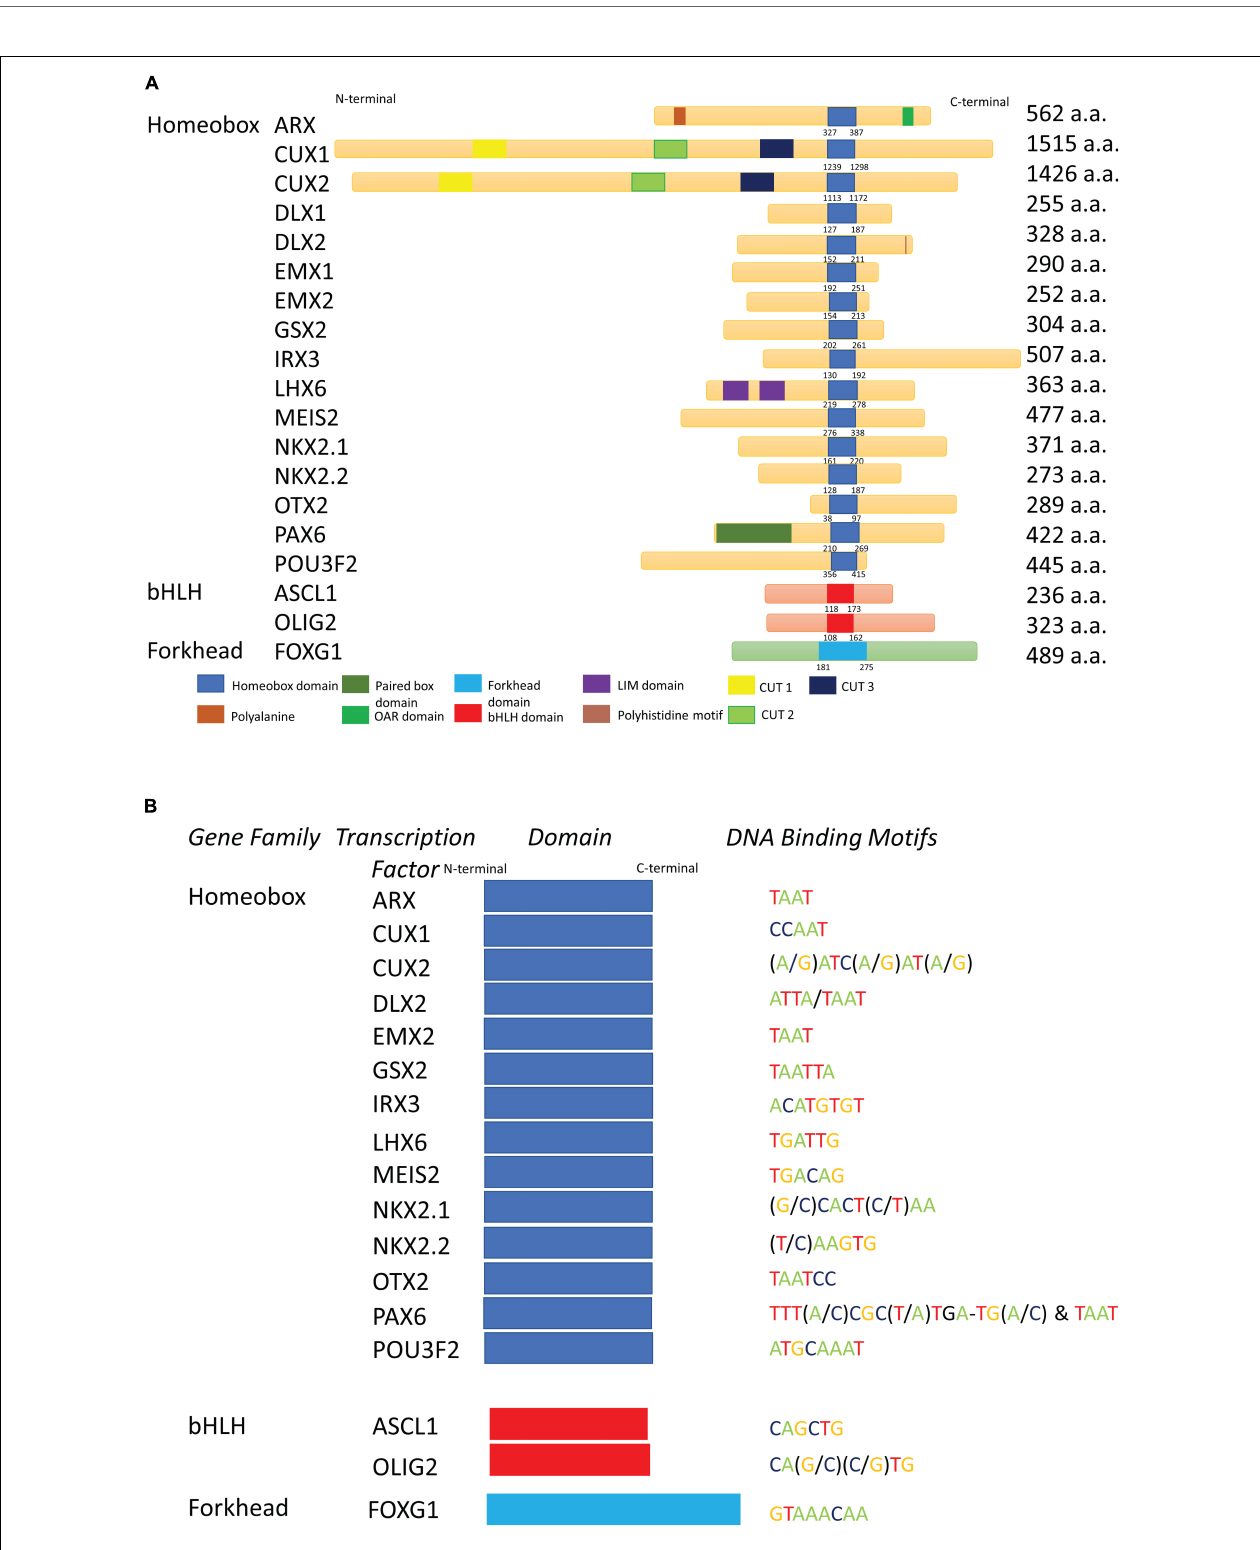
FIGURE 2 | Homeobox transcription factors and their key functional domains. (A) Schematic depiction of the domain structure of selected homeobox, bHLH and forkhead transcription factors illustrating the highly conserved nature of the homeodomains and other DNA-binding domains of these transcription factors. Other significant functional domains are also shown. DLX2, but not DLX1, contains a polyhistidine motif in its C-terminus. PAX6 contains both a paired domain, as well as the HD. ARX, along with a HD, also contains a polyalanine repeat and an Aristaless domain. a.a., amino acid. (B) The DNA binding sites for Homeobox, bHLH and Forkhead transcription factors from (A) . A consensus DNA binding motif for DLX1 and EMX1 is not available.